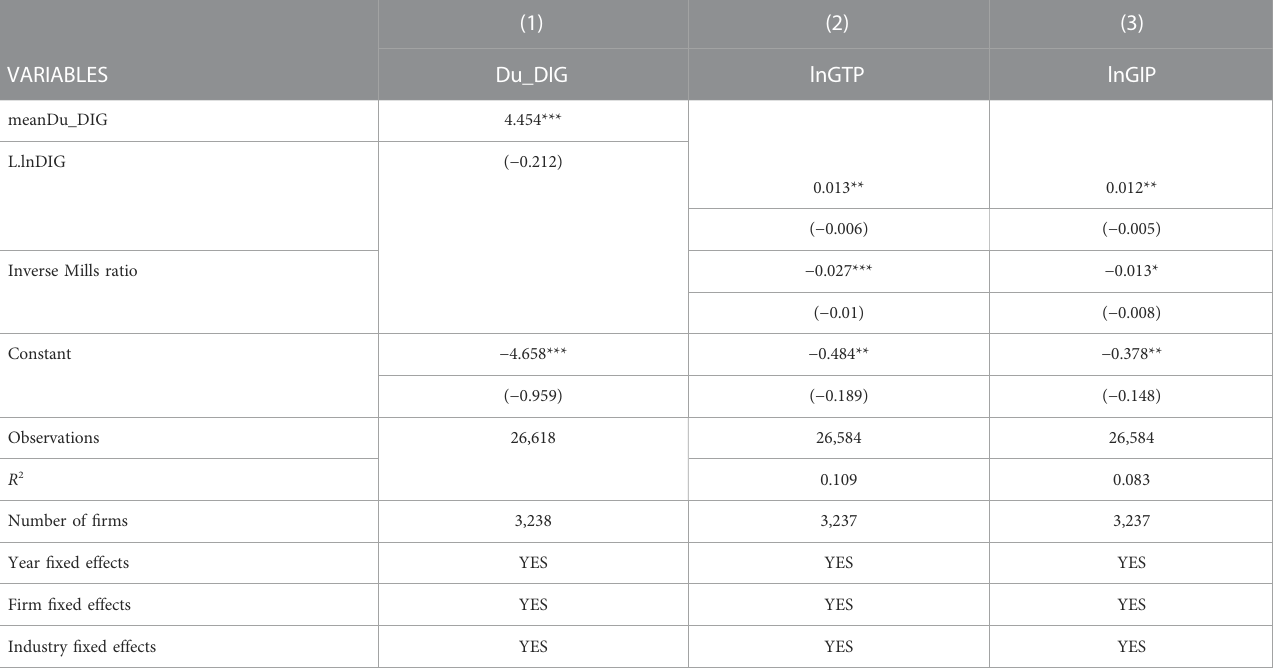
TABLE 7 Heckman two-stage